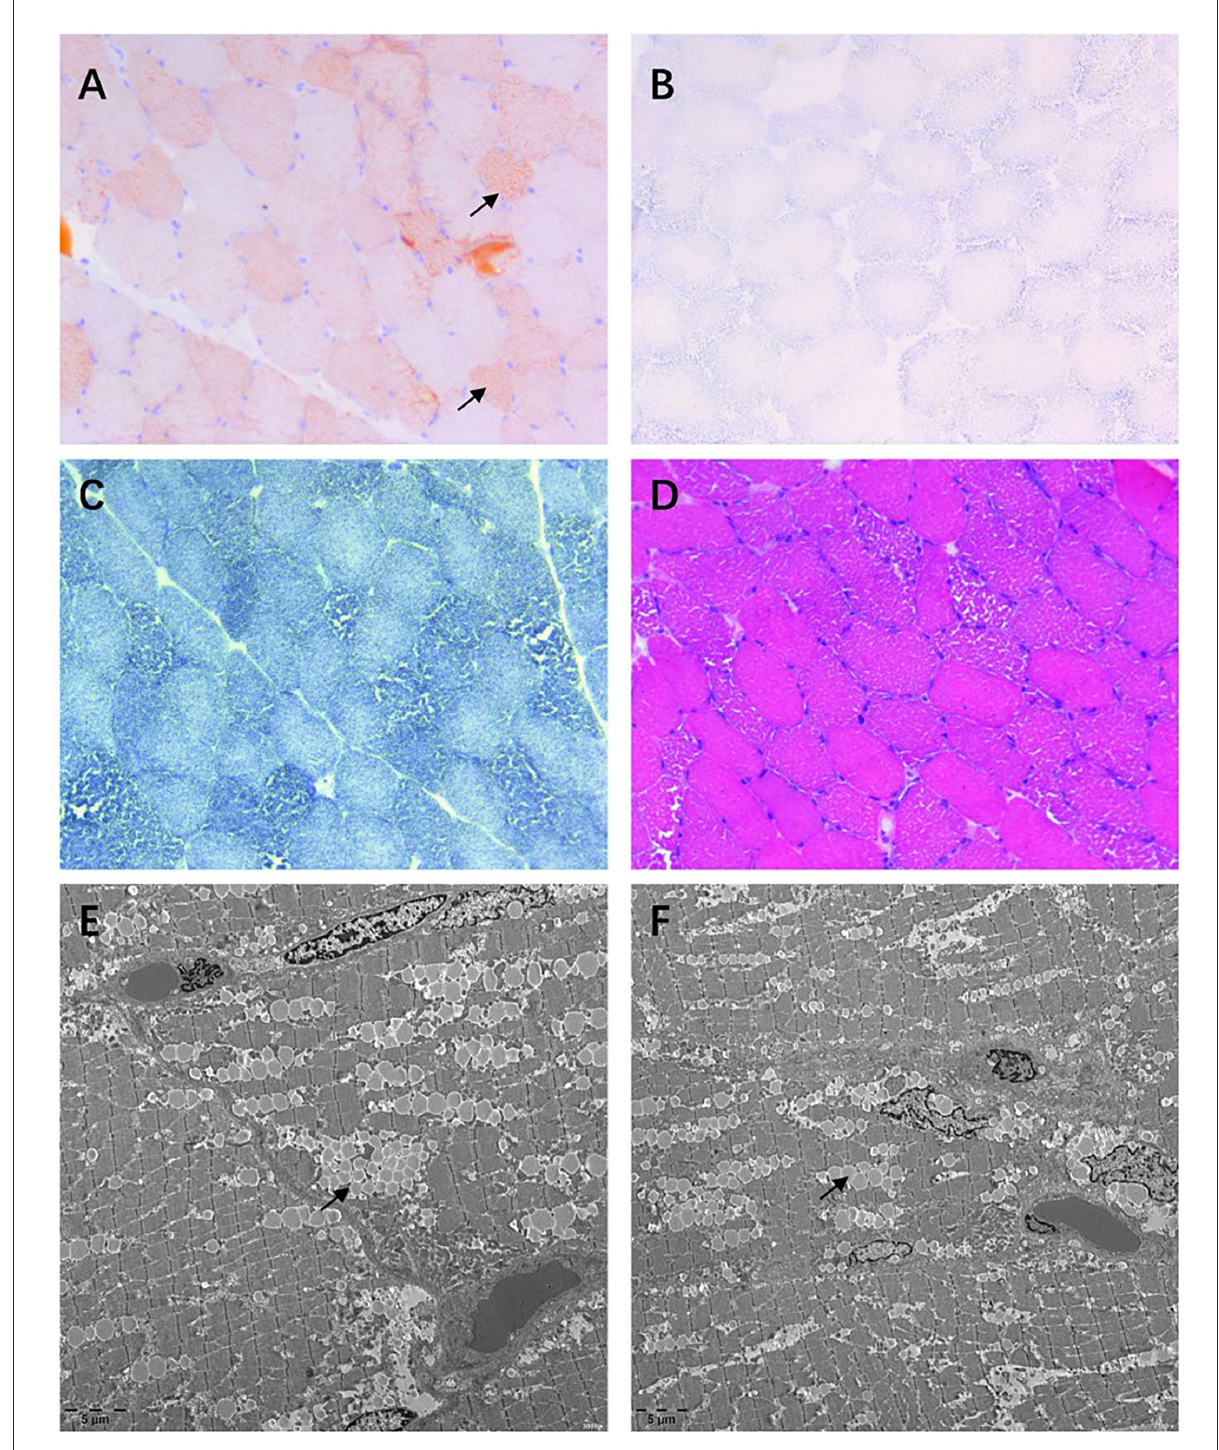
FIGURE1 Muscle biopsy of the quadriceps femoris. (A) Oil Red O (ORO) stain showing lipid droplets deposited in some muscle fibers. (B,C) Lipid droplet is almost invisible in succinate dehydrogenase (SDH) and nicotinamide adenine dinucleotide (NADH) stains. (D) Hematoxylin and eosin (H and E) stain demonstrating abundant vacuoles appearing in most fibers. (E,F) Considerable lipid droplets are observed by transmission electron